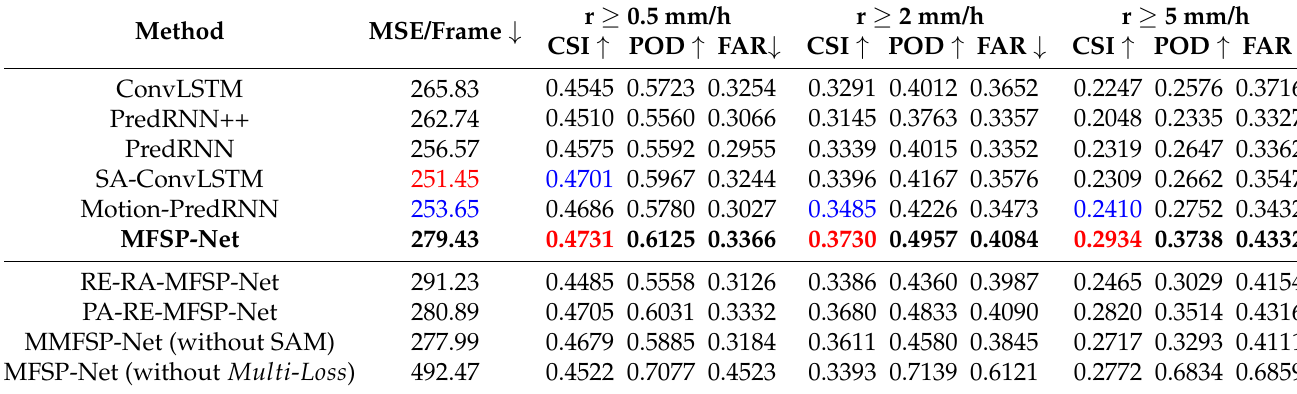
Table 9. Average evaluation results of 20 frames of precipitation intensity nowcasting in the four